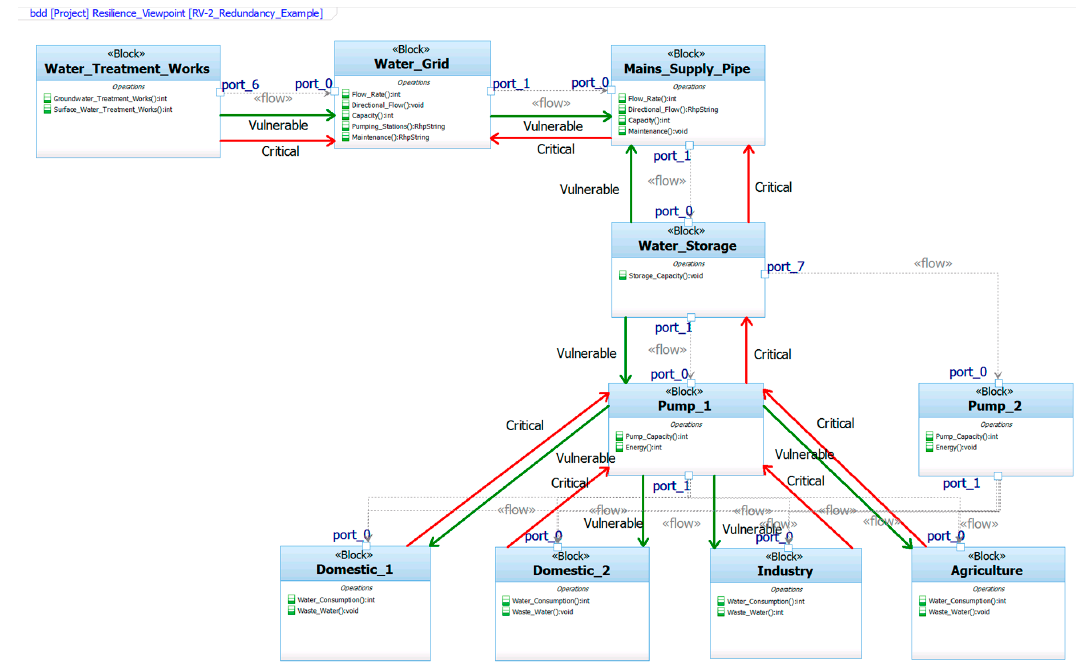
Figure 11. RV-2—Two pump architecture solution.